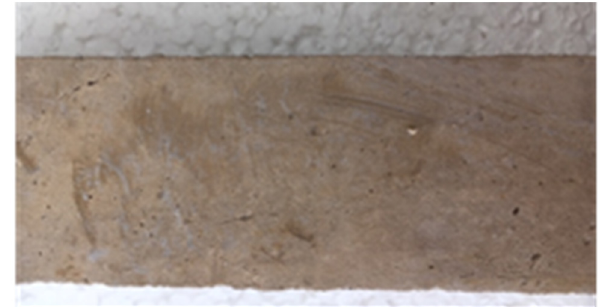
Figure 2. Appearance of the surface of the hardened specimen. The results of the axial contractions recorded are represented in Figure